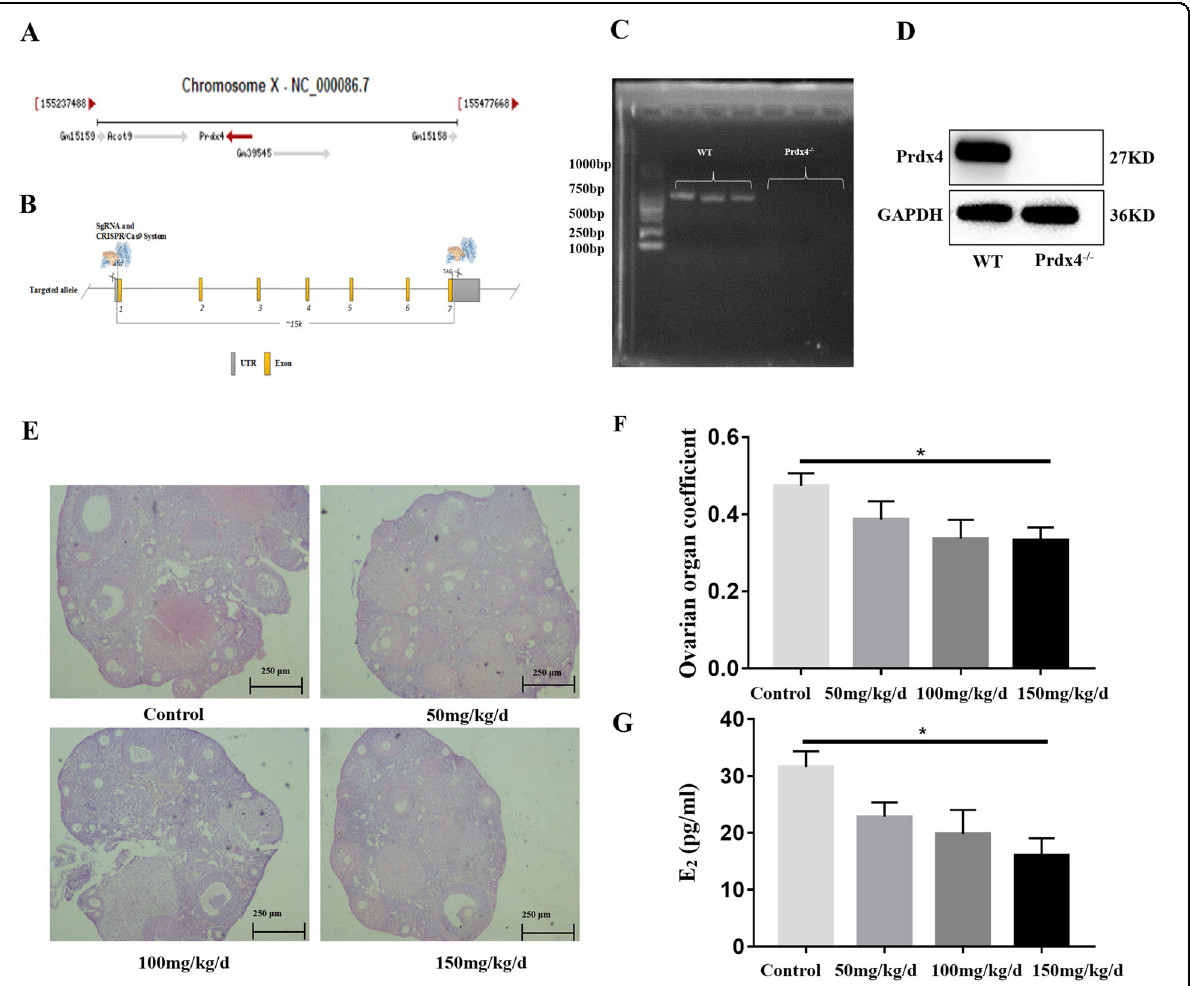
Fig. 1 Establishment of the Prdx4 − / − mouse model and determination of the appropriate D -gal concentration for ovarian ageing induction. a The Prdx4 gene is located on the X chromosome. b Schematic illustration of Prdx4 exons and deletion of exons 1 – 7 by the CRISPR/Cas9 technique. c PCR genotyping of mice. PCR primers for the Prdx4 gene were as follows: forward, CCAGTATACAGTCTGATATGG, and reverse, TAGCTGGATATGTTAGCACT. These primers generated a 700-bp product. Genes from wild-type mice (lanes 1, 2, and 3) and Prdx4 − / − mice (lanes 4, 5, and 6) were ampli fi ed with speci fi c primers. d Immunoblotting analysis of Prdx4 protein expression in the control and Prdx4 − / − groups. The blot